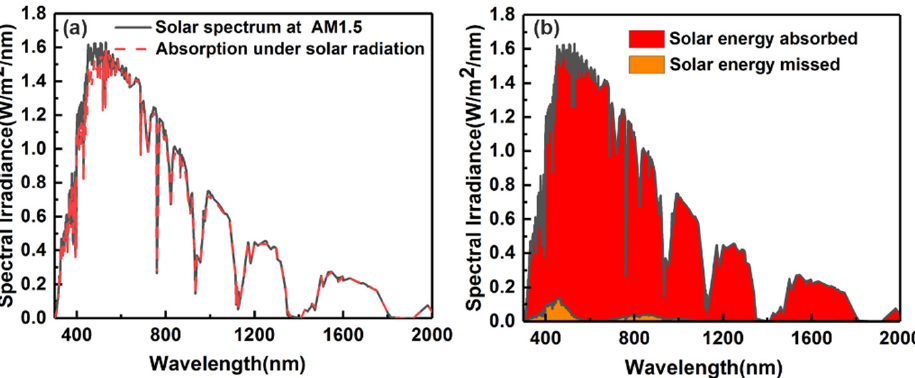
Figure 12. ( a ) Comparison of the AM 1.5 standard spectrum of solar radiation and the absorbed spectrum. ( b ) The energy absorbed and lost by the absorber under AM 1.5.